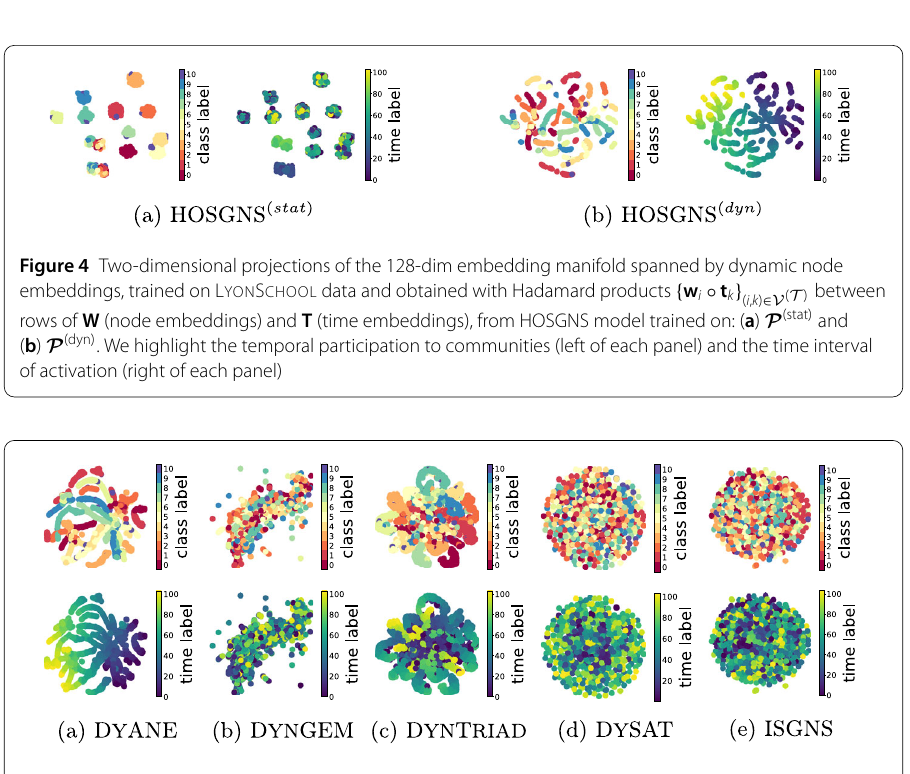
Figure 5 Two-dimensional projections of the 128-dim embedding manifold spanned by dynamic node embeddings for L YON S CHOOL data learned with baseline methods. As in Fig. 4 we highlight the temporal participation to communities (top of each panel) and the time interval of activation (bottom of each